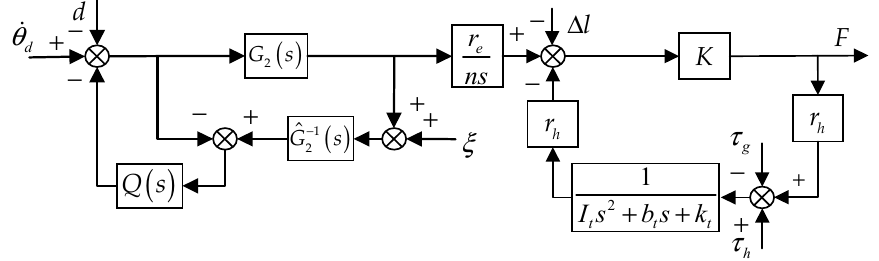
Figure 5. The block diagram of the inner loop based on DOB.